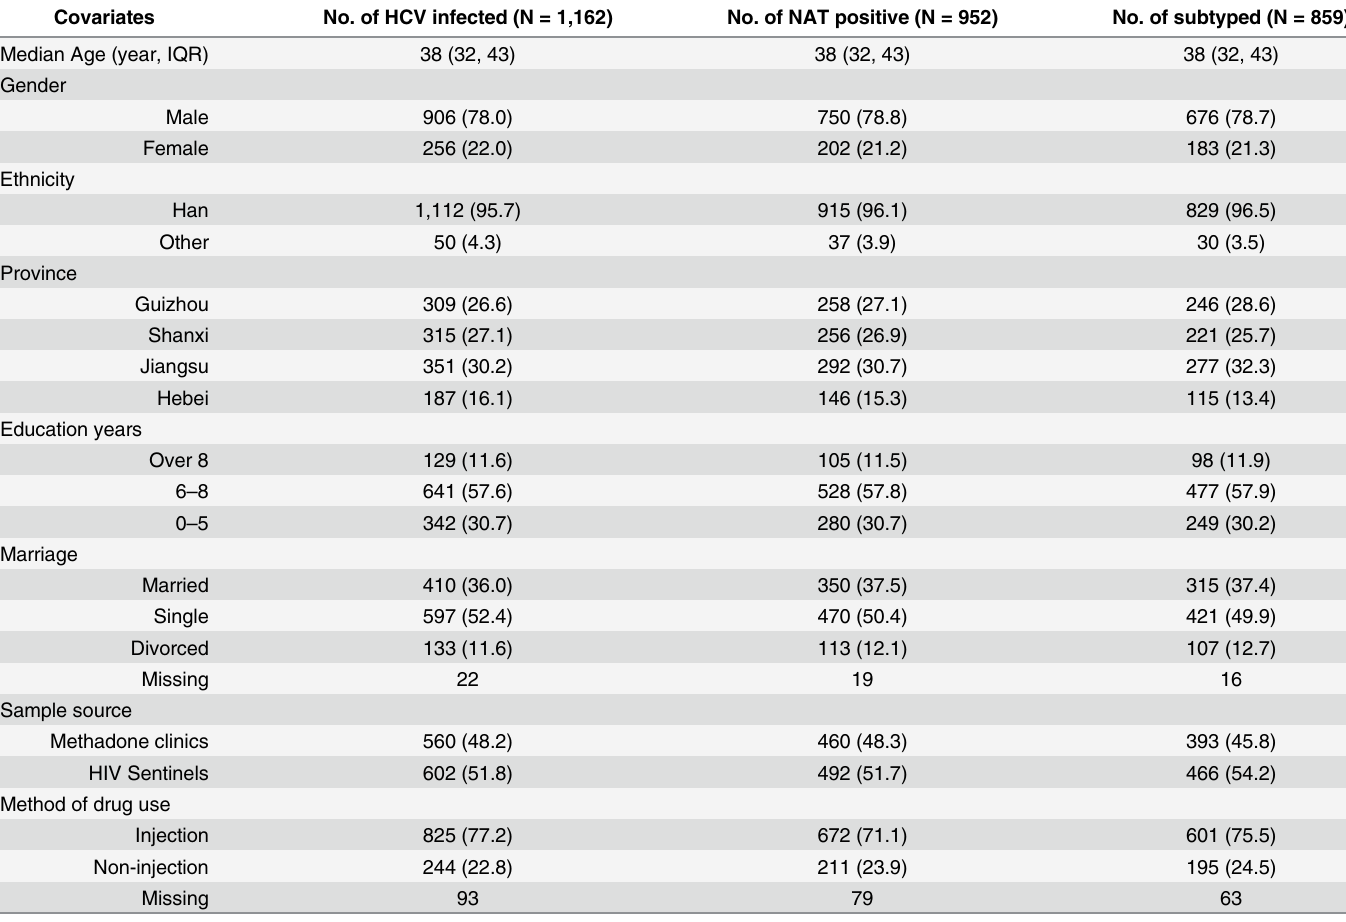
Table 1. Description of demographic and behavioral characteristics among HCV-infected drug users in